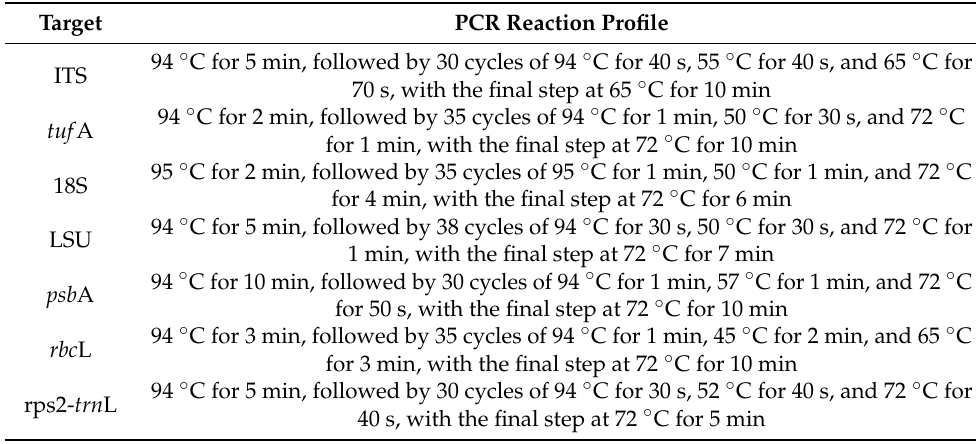
Table 2. Polymerase chain reaction profiles for different gene.